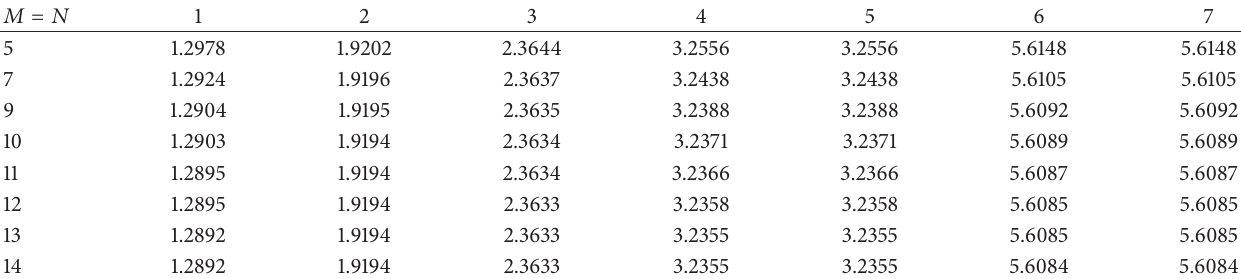
Table 1: The first seven frequency parameters Ω = ( 𝜔𝑏 2 /𝜋 2 )( 𝜌ℎ/𝐷 ) 1/2 for F-F-F-F Mindlin rectangular plates.